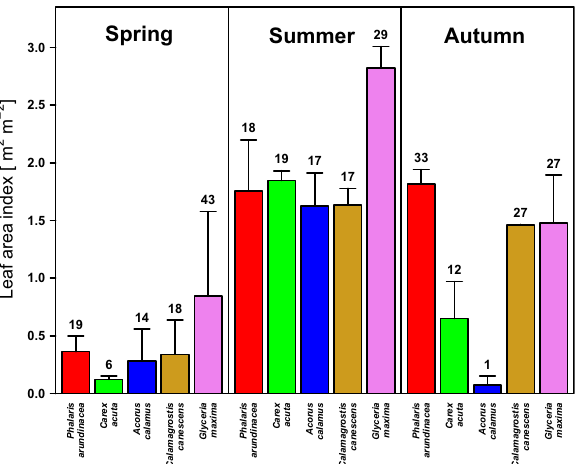
Figure 3. Leaf area index (LAI) of individual dominant plant species of the sedge-grass marsh during different growth periods: spring, summer and autumn. Average LAI values are presented with standard errors of mean (SE). Numbers above the SE-indicating abscissae are percentages of total LAI formed by each of the five dominant plant species in each growth